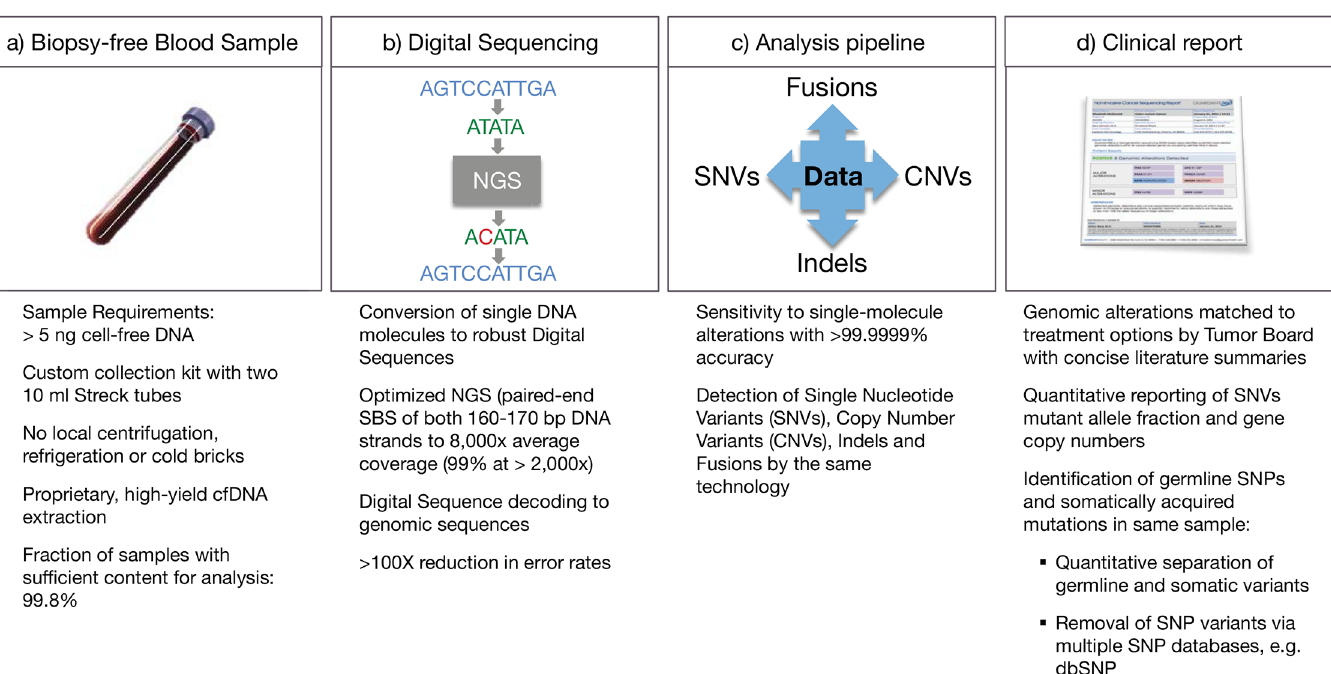
Fig 1. Workflow for the Guardant360 cell-free circulating DNA NGS genomic profile. (a) cfDNA is extracted from a routine blood draw. (b) 5.0 – 30 ng of DNA undergoes digital library preparation including oligonucleotide barcoding of each strand in each individual DNA fragment. Complete sequencing of 512 exons in 54 cancer-related genes is conducted with the HiSeq 2500 (Illumina). Multi-analyte algorithms and bioinformatics are used to reconstruct the progenitor cfDNA fragment sequences without false positives. (c) Sequence data are processed using a customized analysis pipeline designed to accurately detect the four major classes of genomic alterations. (d) Mutant allele fractions are reported quantitatively for somatic single nucleotide variants of clinical significance and distinguished from germline single nucleotide variants (SNVs) by reference to the COSMIC and dbSNP databases, as well as their